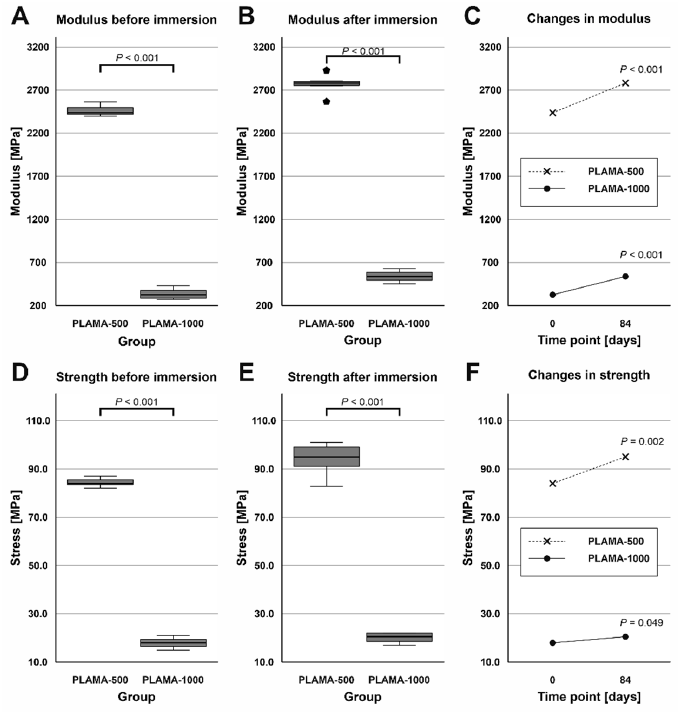
Figure 13. Comparison of the flexural modulus of PLAMA-500 and PLAMA-1000 before and after the SBF immersion test ( A , B ); changes in the modulus in both groups ( C ); comparison of the ulti- mate flexural strength of PLAMA-500 and PLAMA-1000 ( D , E ); changes in the strength in both groups ( F ).